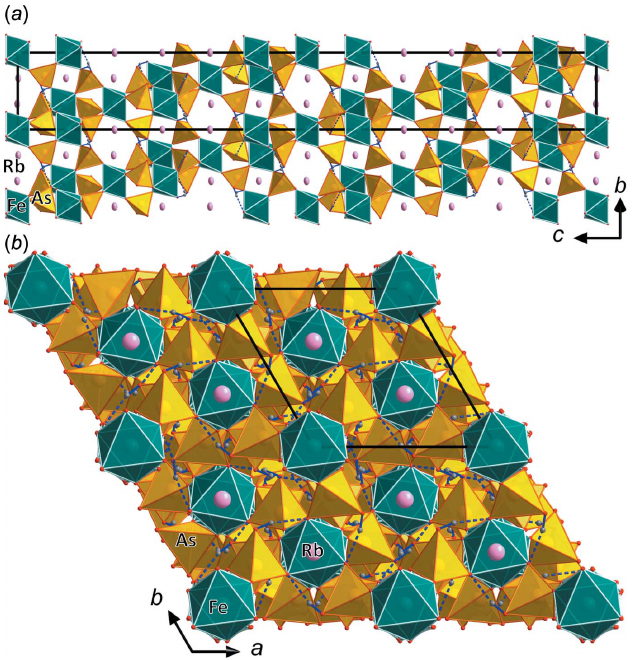
Figure 2 Structure drawing of RbFe(HAsO 4 ) 2 along ( a ) [100] and ( b ) [001]. The Rb atoms, located in channels of the framework structure, are shown with displacement ellipsoids at the 70% probability level. Hydrogen bonds are shown as dashed lines.